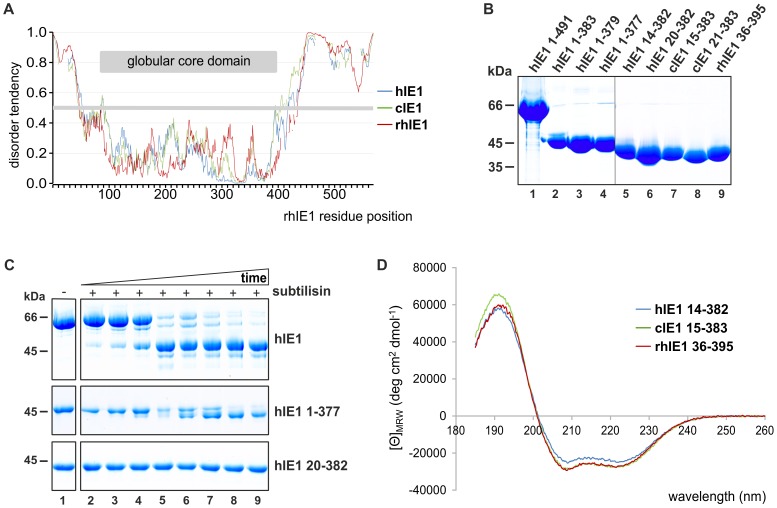
The IE1 proteins of the primate cytomegaloviruses human (h), chimpanzee (c) and rhesus (rh) cytomegalovirus contain a conserved, stably folded globular core domain.(A) In silico analysis of the hIE1, cIE1 and rhIE1 sequences using IUPred [39]. Disorder score for IE1 suggesting the presence of a central folded globular domain (scores <0.5; gray box). Scores ≥0.5 (gray line) indicate disorder. (B) Prokaryotic expression and purification of hIE1, cIE1 and rhIE1 proteins used for crystallization attempts. The panel shows a Coomassie blue stained SDS-PAGE of the purified proteins as indicated. (C) Experimental confirmation of the folded globular IE1 domain (IE1CORE) by limited proteolysis. Full-length (1–491), C-terminally truncated (1–377) or N/C-terminally truncated (20–382) hIE1 protein was incubated with subtilisin and analyzed at different time points (e.g. at 1, 10, 30, 60, 120, 180, 240 and 300 min) by SDS-PAGE and Coomassie blue staining. (D) Circular dichroism analysis of the hIE1(14–382), cIE1(15–383) and rhIE1(36–395) core domains indicating a conserved, highly α-helical fold.